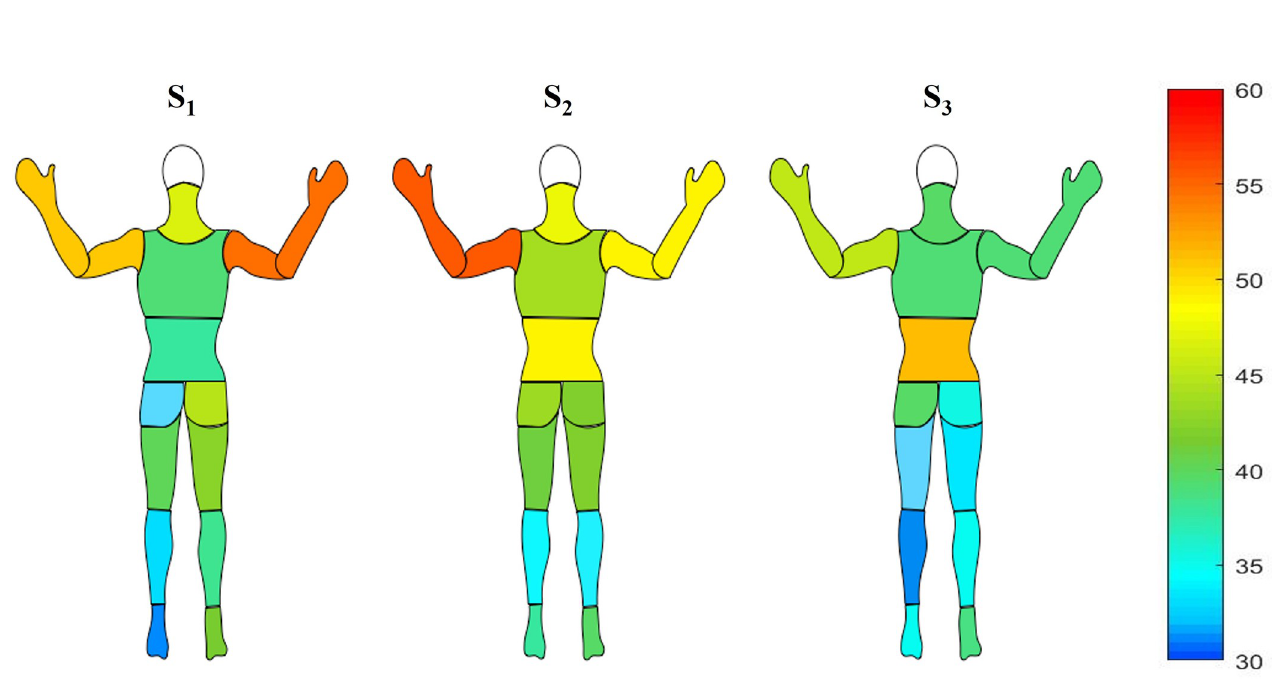
Fig 5. Local discomfort scores according to each body part for each seat.